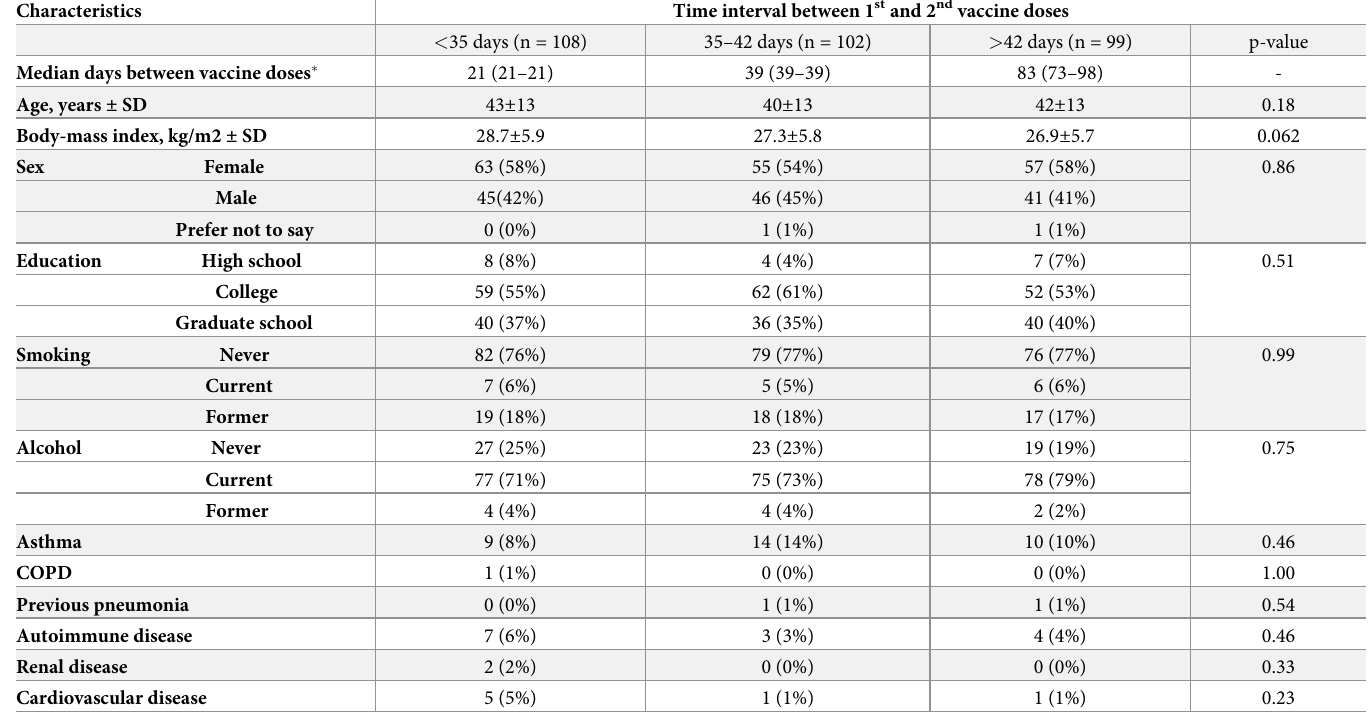
Table 1. Baseline characteristics of participants by dosing interval.